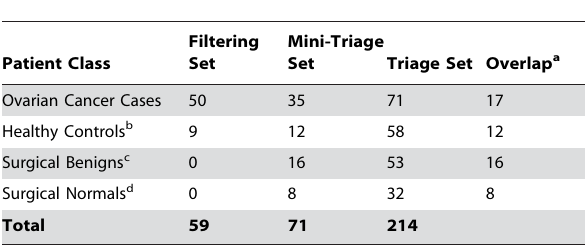
Table 1. Marker evaluation pipeline: cases and